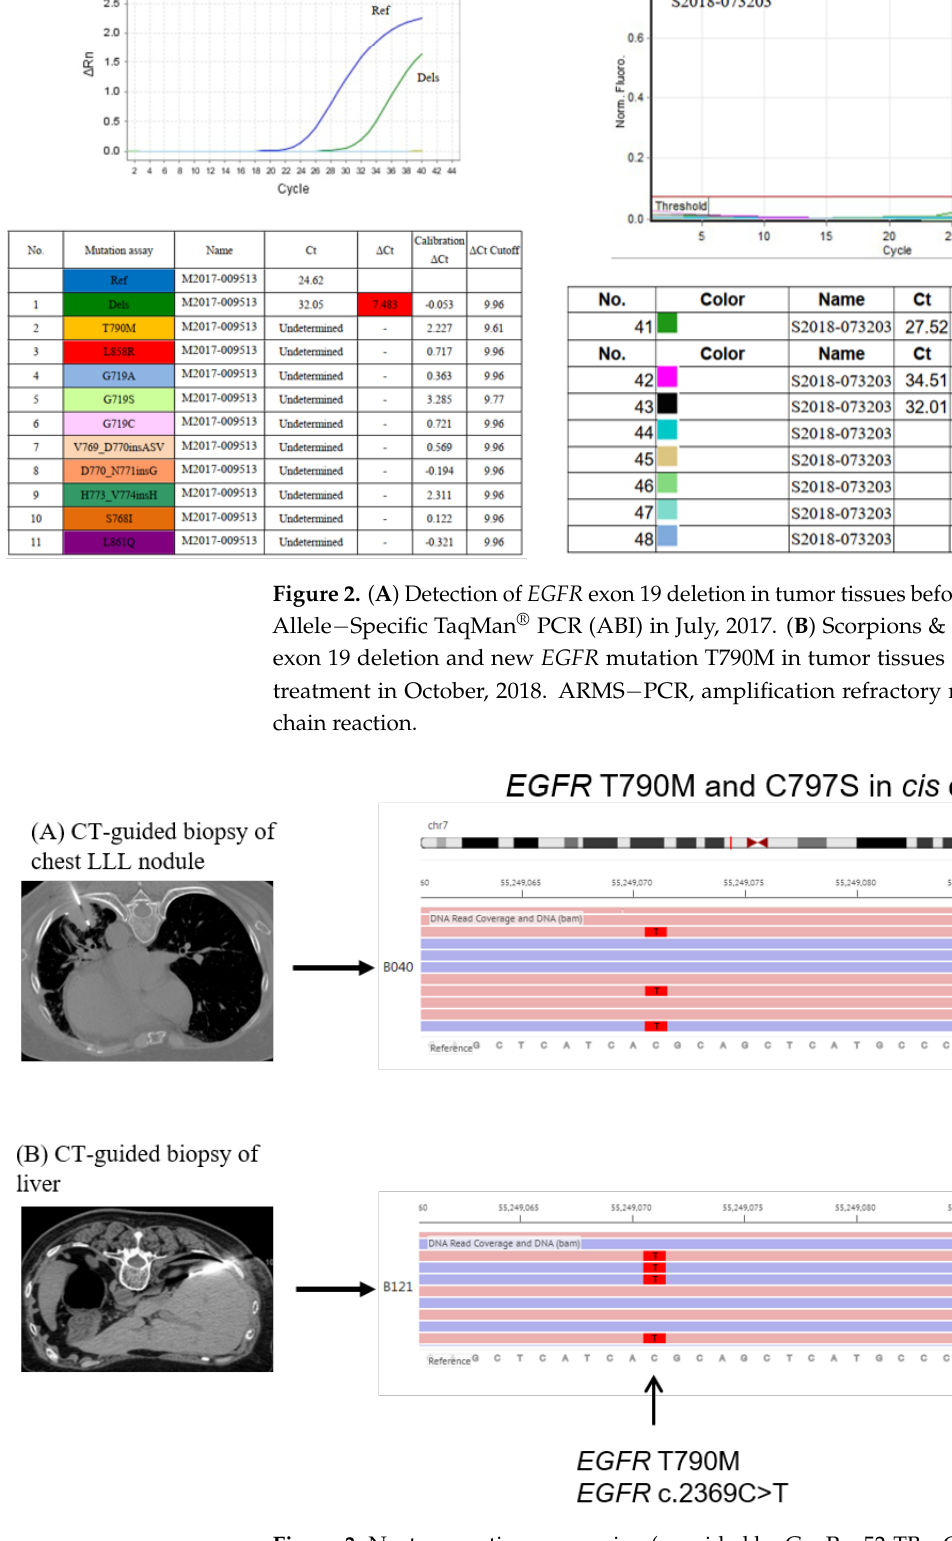
Figure 4. During immunochemotherapy, the patient had headache and dizziness. Brain magnetic resonance imaging (MRI) showed focal metastasis in the parietal skull (middle panel in October 2021). Three months after brigatinib treatment, the skull lesion regressed (right panel in January 2022). 3. Discussion Herein, we reported a patient with NSCLC harboring EGFR 19del-T790M-cis-C797S mutation and was treated with brigatinib monotherapy as fourth-line treatment after pre- vious treatment of afatinib, osimertinib, and immunochemotherapy. Of all triple EGFR mutations in patients receiving second-line osimertinib monother- apy (such as our case), C797S is the most common mutation, accounting for about 24% [11,14]. Additionally, both C797S in cis- and trans-form with T790M may present. It was reported that most mutations of C797S were in cis form with maintained T790M rather than that in trans-form [15]. When tumors develop T790M-cis-C797S mutations, limited